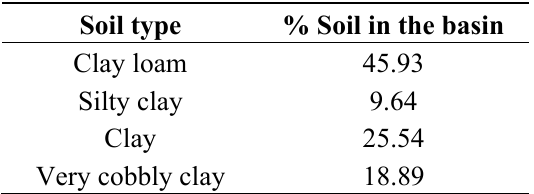
Table 2. Different soil types in the watershed.